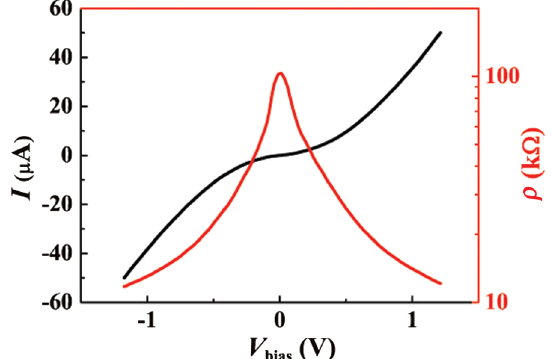
FIG. 15. The black curves represent the I-V curve at 10 K for sample C. The red curve is the derived resistance per square. The resistance at small bias voltage is around 100 k Ω , which is much larger than h=e 2 . Hence, the existence of a conducting edge state is not